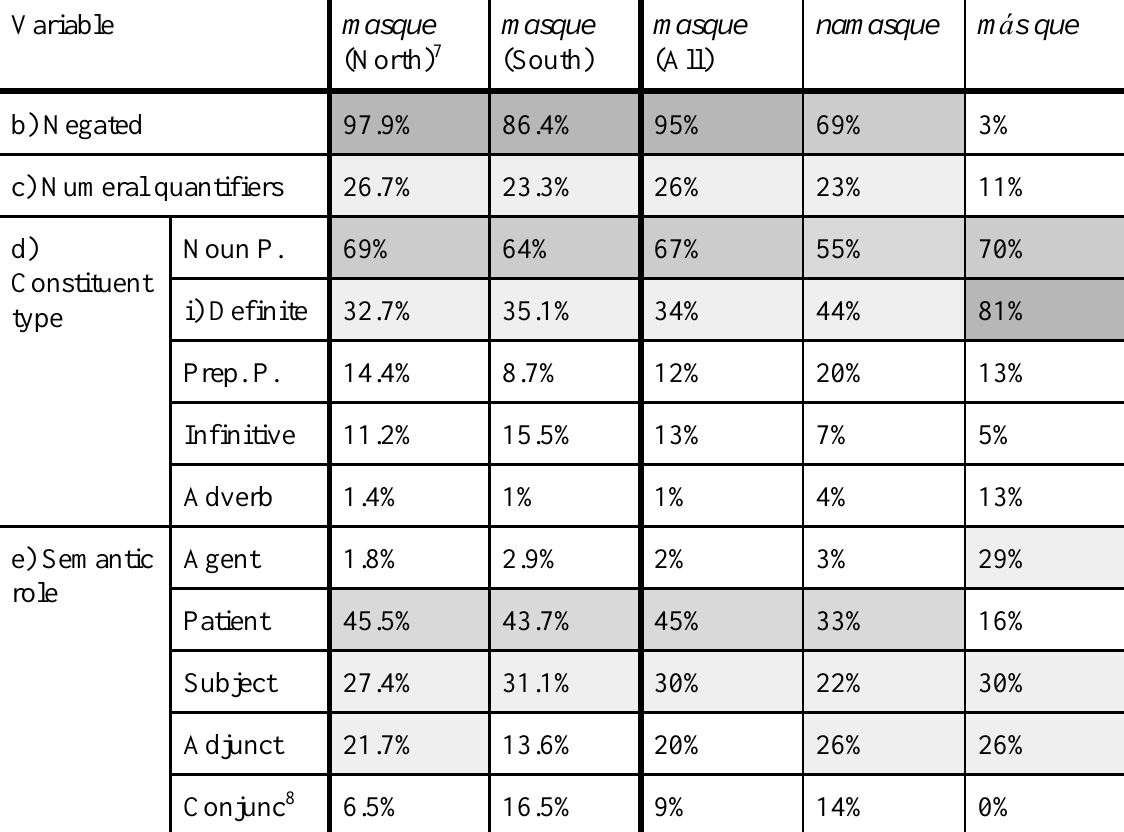
Table 1. Types of más que and associated properties in COSER